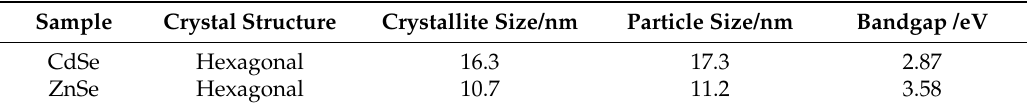
Table 2. Crystal structure, size and optical band gap of CdSe and ZnSe